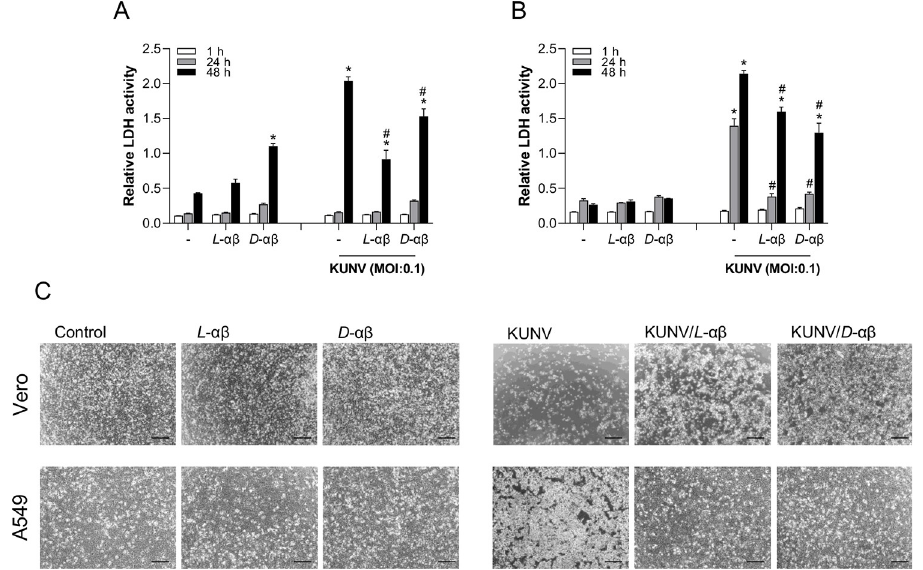
Fig 6. PLNC8 αβ counteracts virus-induced cytotoxicity. KUNV was either left untreated or exposed to 10 μ M of L - PLNC8 αβ (L- αβ ) or D -PLNC8 αβ (D- αβ ) for 1 h. Relative cytotoxicity of A - Vero cells and B - human lung epithelial cells (A549) was determined after exposure to PLNC8 αβ , KUNV, or PLNC8 αβ -treated KUNV for 1 h, followed by replacement of the cell culture media to DMEM, supplemented with 2.5% FBS. C - representative images of Vero- and A549 cells after 48 h and 24 h of infection/exposure, respectively. Scale bar is 50 μ m. The data are presented as mean with SEM, and statistics at one significance level (p < 0.05) were analysed using one-way ANOVA with Dunnett´s multiple comparison test (n = 3, significance compared to the unexposed negative control � and KUNV-infected control # ).